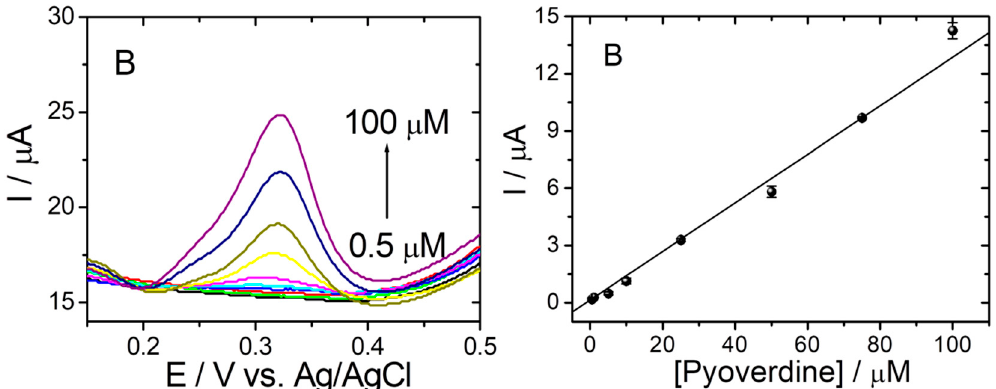
Figure 5. ( A ) DPVs in 20 mM PBS pH 7.4 without PyoV (black line) and for different concentrations of PyoV: 0.5 (green line); 0.75 (red line); 1 (dark blue line); 5 (light blue line); 10 (purple line); 25 (yellow line); 50 (olive line); 75 (blue line); and 100 (dark purple line) µ M in 20 mM PBS pH 7.4 on graphene/graphite after reduction and AuNPs decoration SPE. ( B ) Calibration plot of PyoV concentration vs. current (error bars represent the standard deviation for three tests).